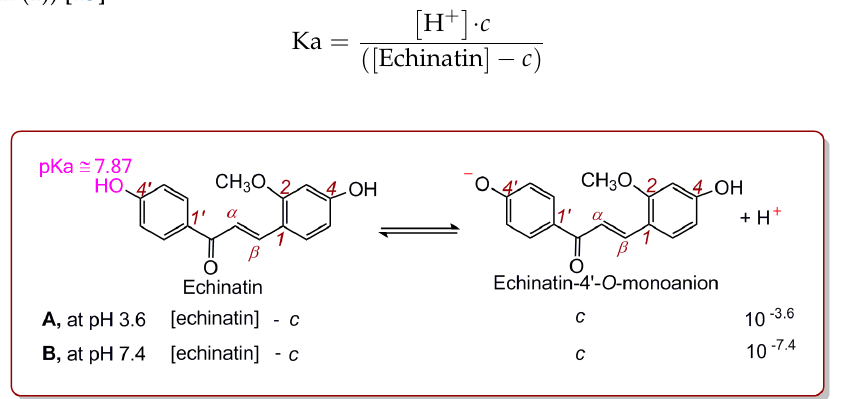
Figure 3. Ionization equilibrium of the 4 ′ -OH group in echinatin at pH 3.6 (A) and 7.4 (B).